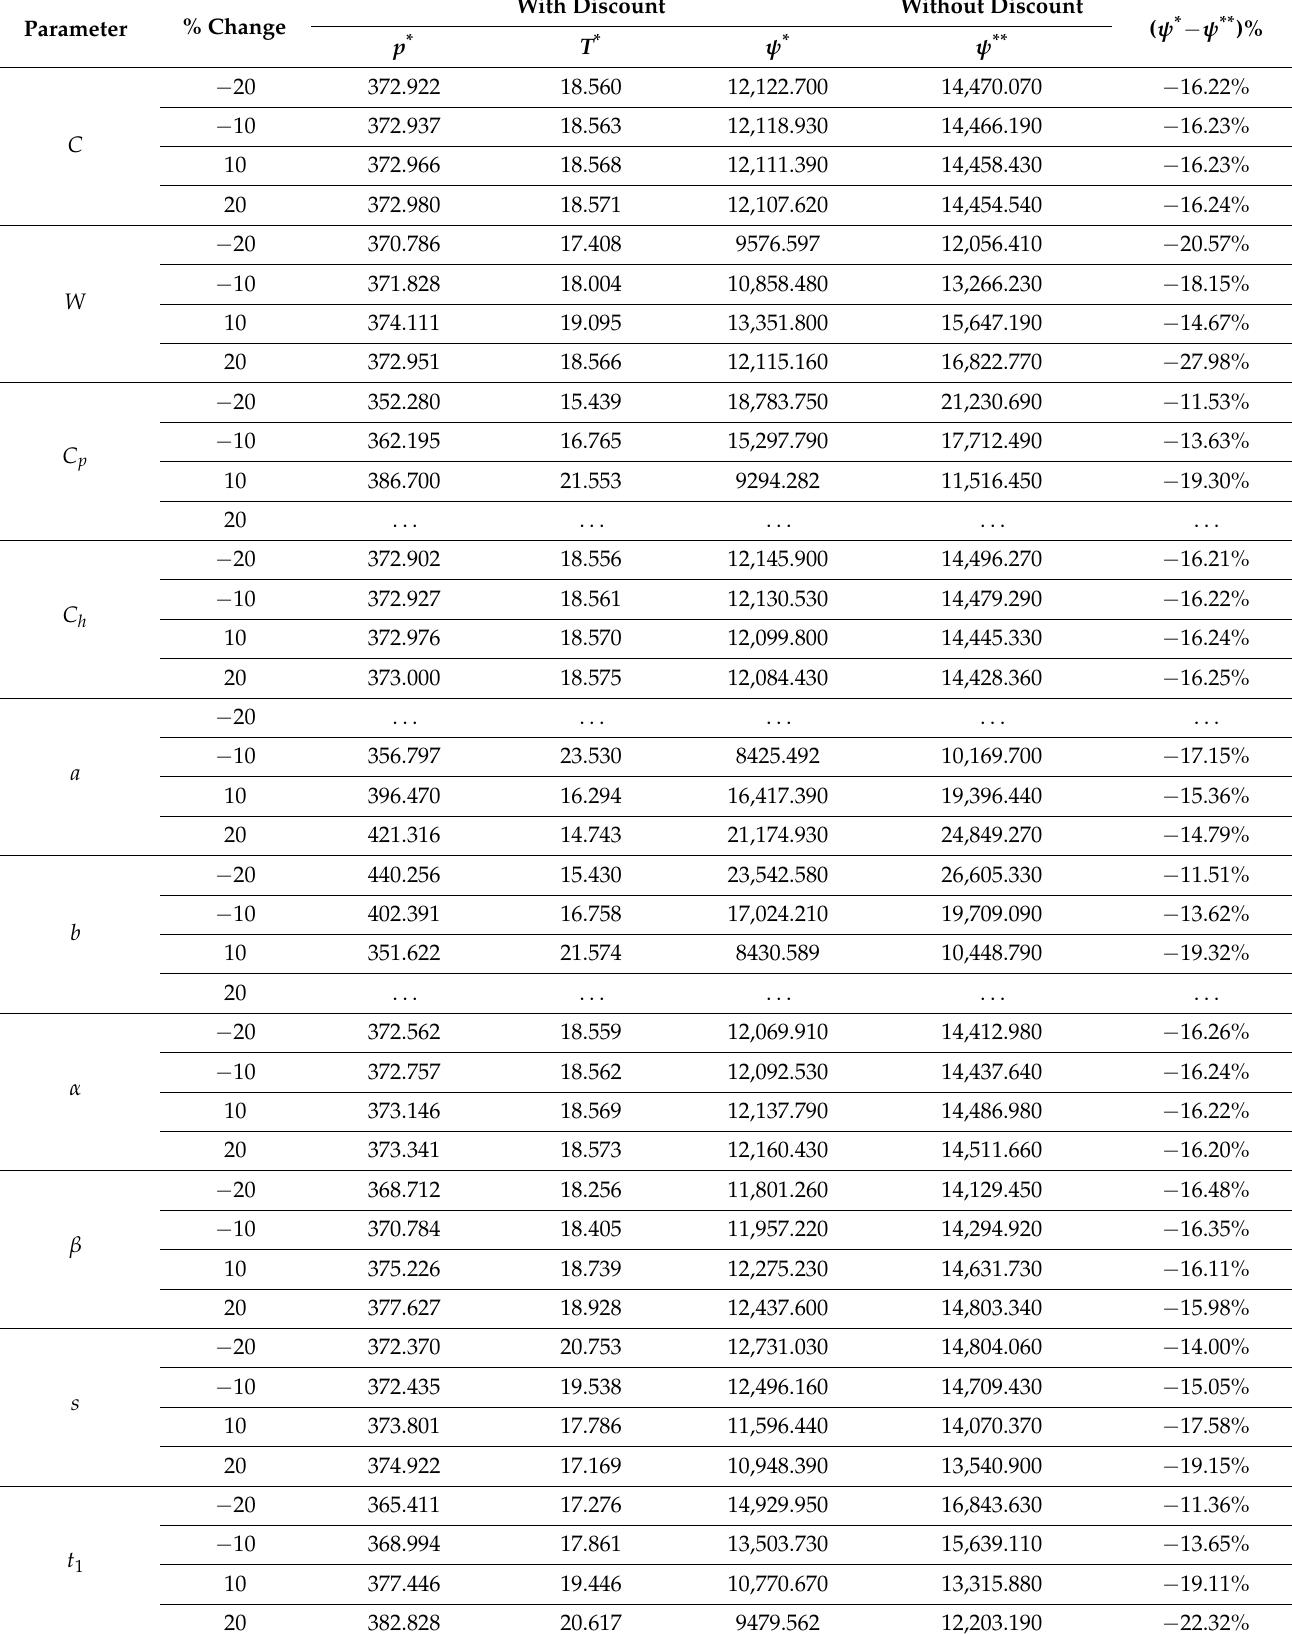
Table 3. Sensitivity analysis relating to altered